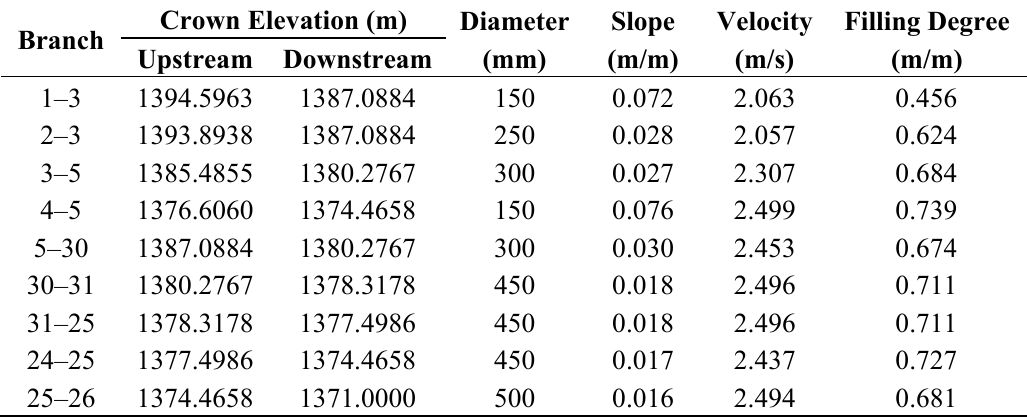
Table 4. World Bank (1991) [61] case study. Optimal decision variables and hydraulic